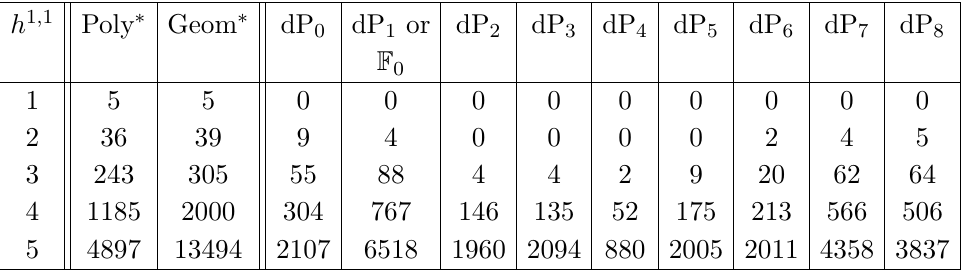
Table 6 . Number of CY geometries with a particular type of del Pezzo divisor. h 1 , 1